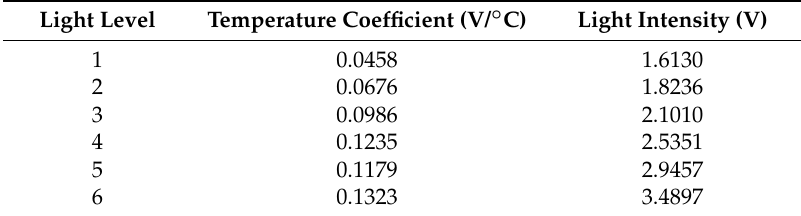
Table 3. PA temperature coefficient and light intensity.